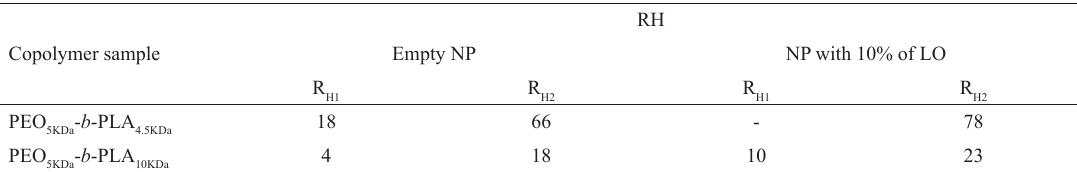
) values for PEO- b -PLA self-assembled systems with and without lavender oil (LO). Table 1: Hydrodynamic radius (R H Copolymer